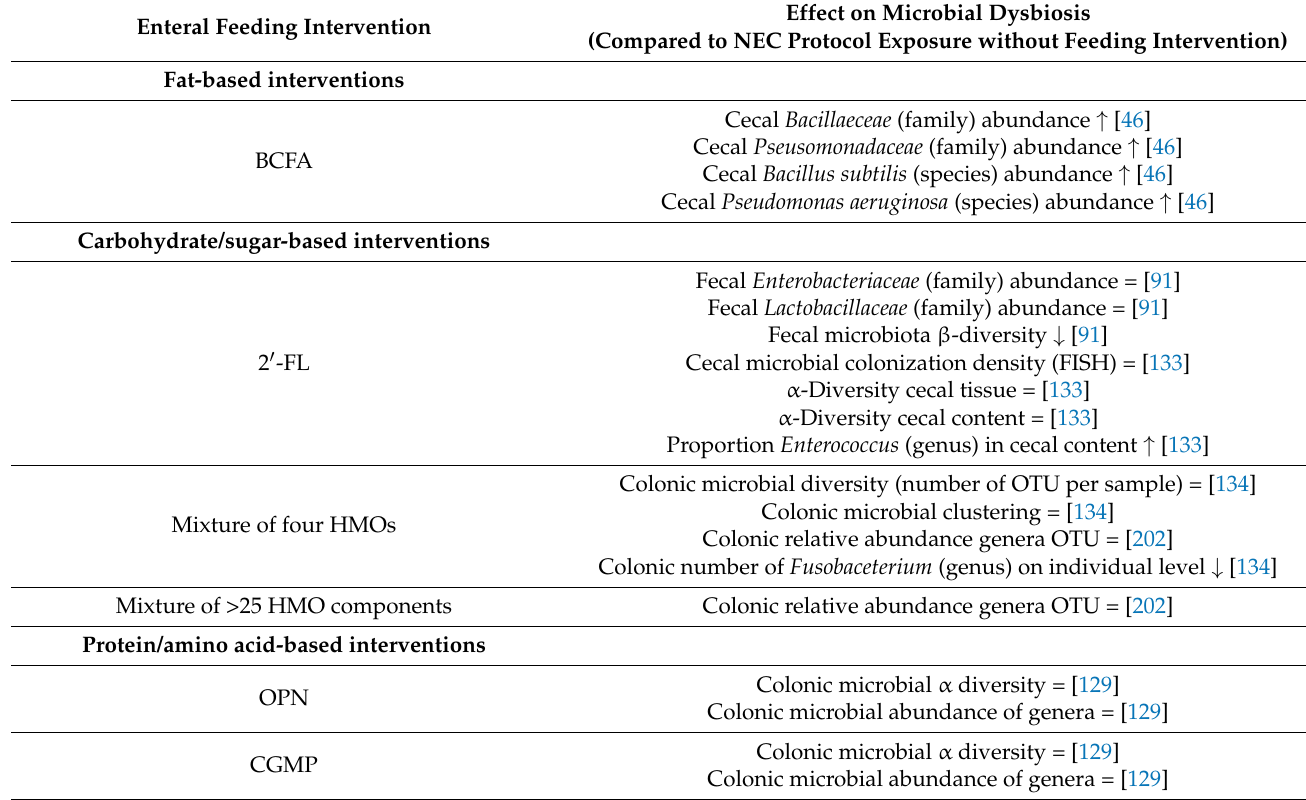
Table 11. Effect of enteral feeding interventions that affect microbial dysbiosis in experimental animal models of NEC. Effect on Microbial Dysbiosis Enteral Feeding Intervention (Compared to NEC Protocol Exposure without Feeding